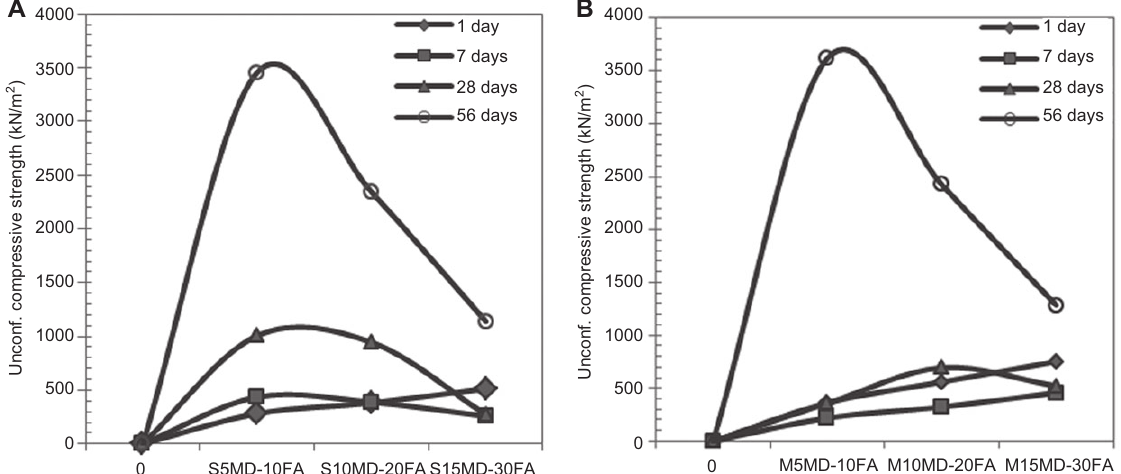
Figure 3 Unconfined compressive strength. (A) Specimens with SPE. (B) Specimens with